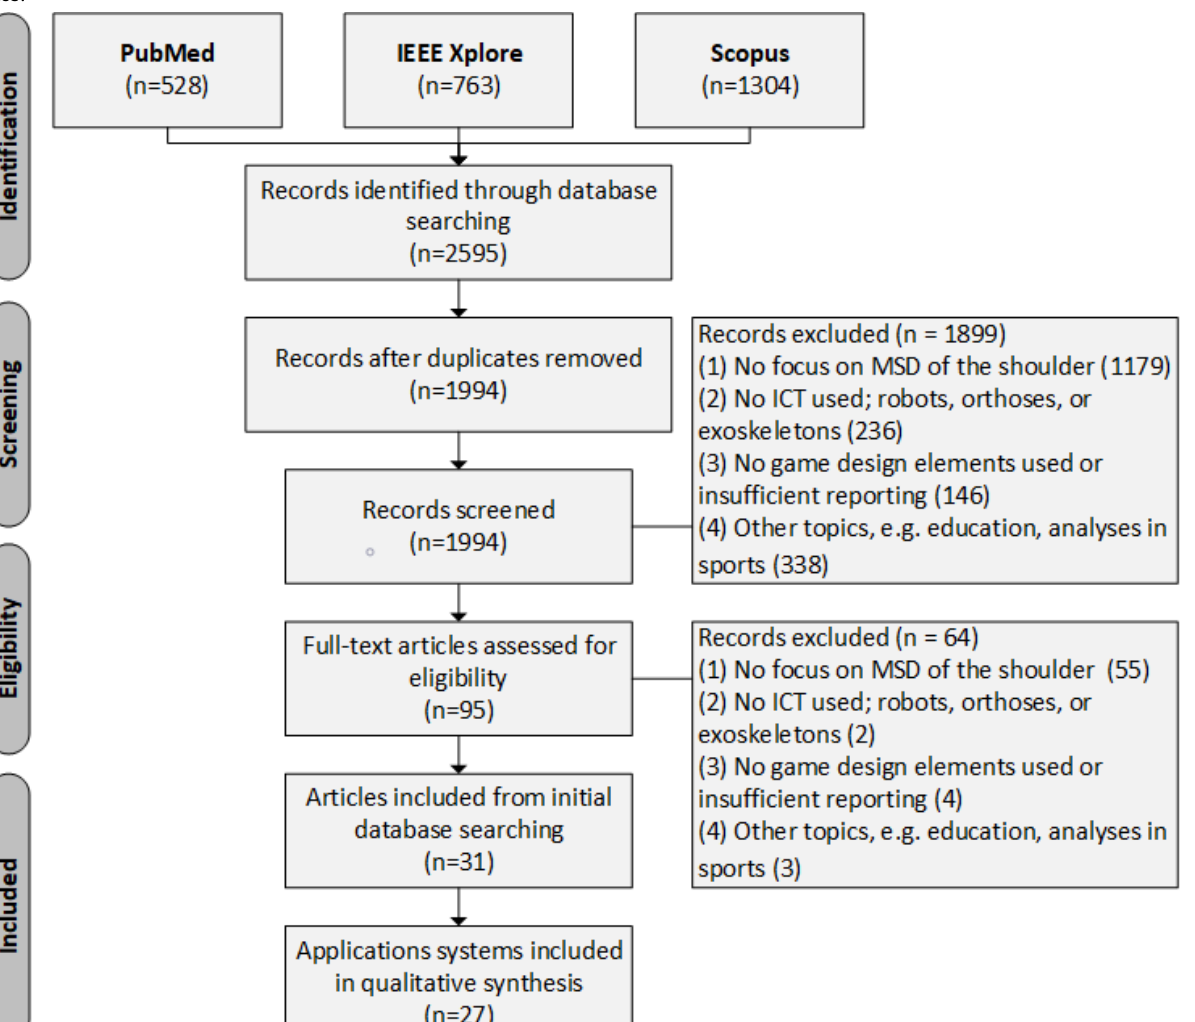
Figure 1. PRISMA Flow diagram for the identification of application systems. ICT: information communication technology; MSD: musculoskeletal